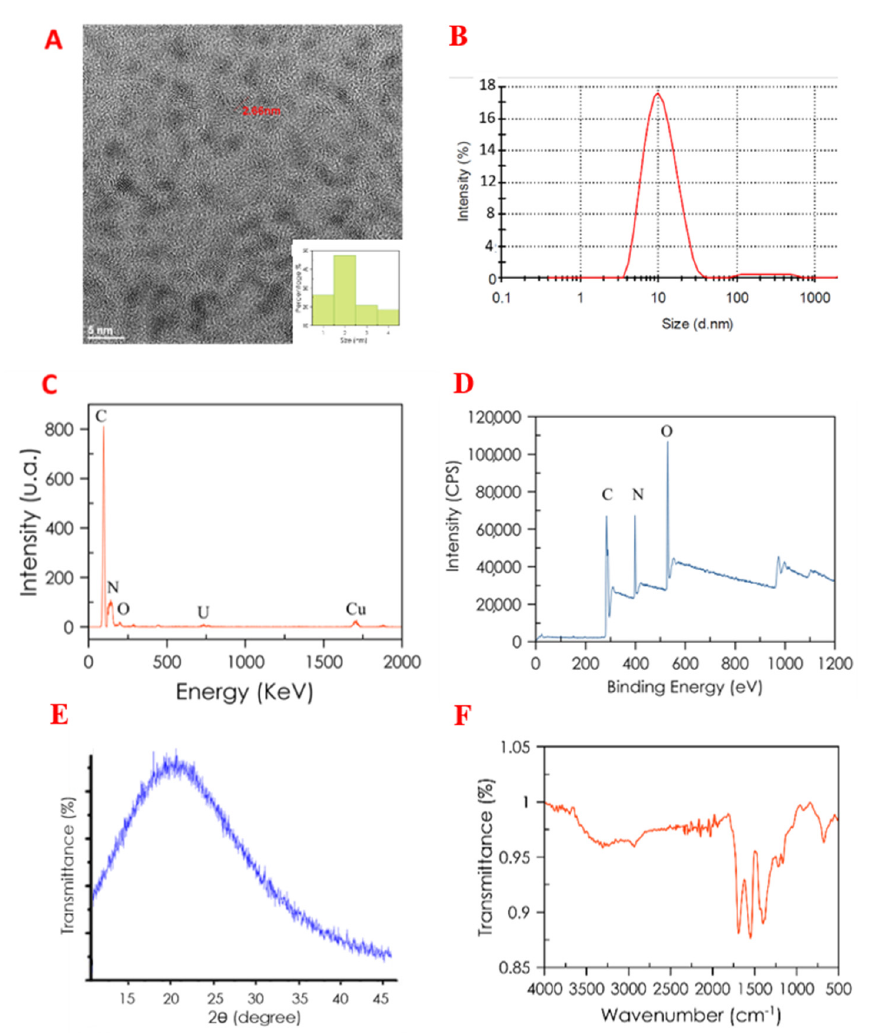
Figure 3. Characterization of carbon dots (CDs). ( A ) HR-TEM image; ( B ) CDs size distribution using DLS; ( C ) EDX spectrum. ( D ) XPS spectra: C1s peak: 284 eV; N1s peak: 398 eV, and O1s peak: 530 eV. ( E ) XRD pattern and ( F ) FTIR spectrum of CDs.